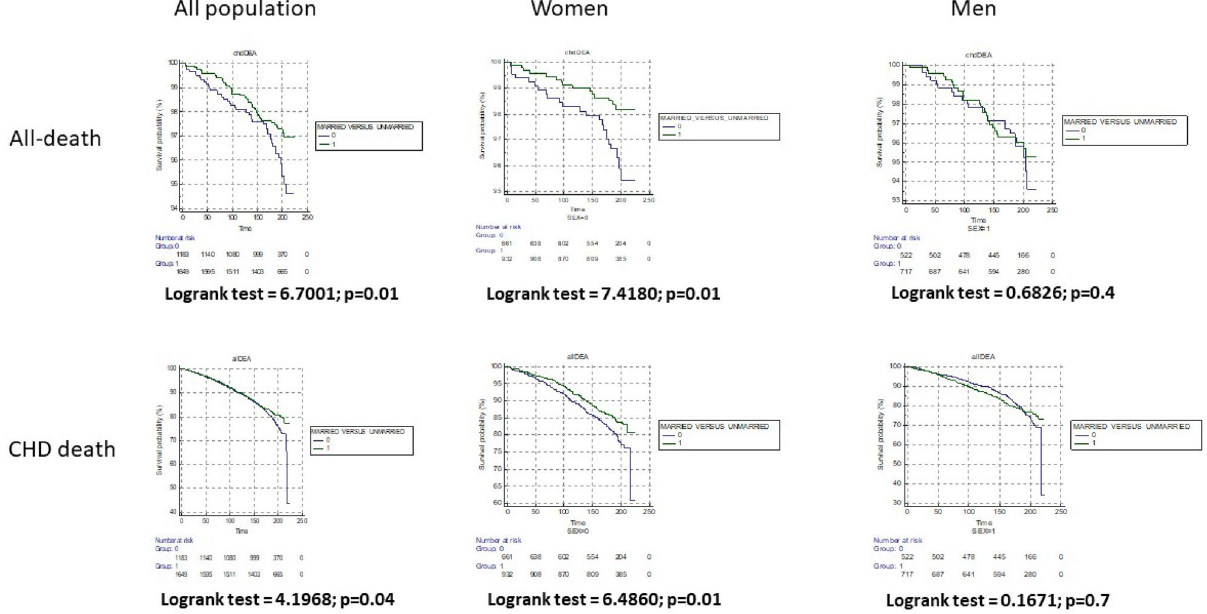
Figure 2. Kaplan–Meier graphs of crude all-death and coronary heart disease death rates during approximately 20 year in men and women from Gubbio Population Study in function of marital status (married versus unmarried). CHD coronary heart